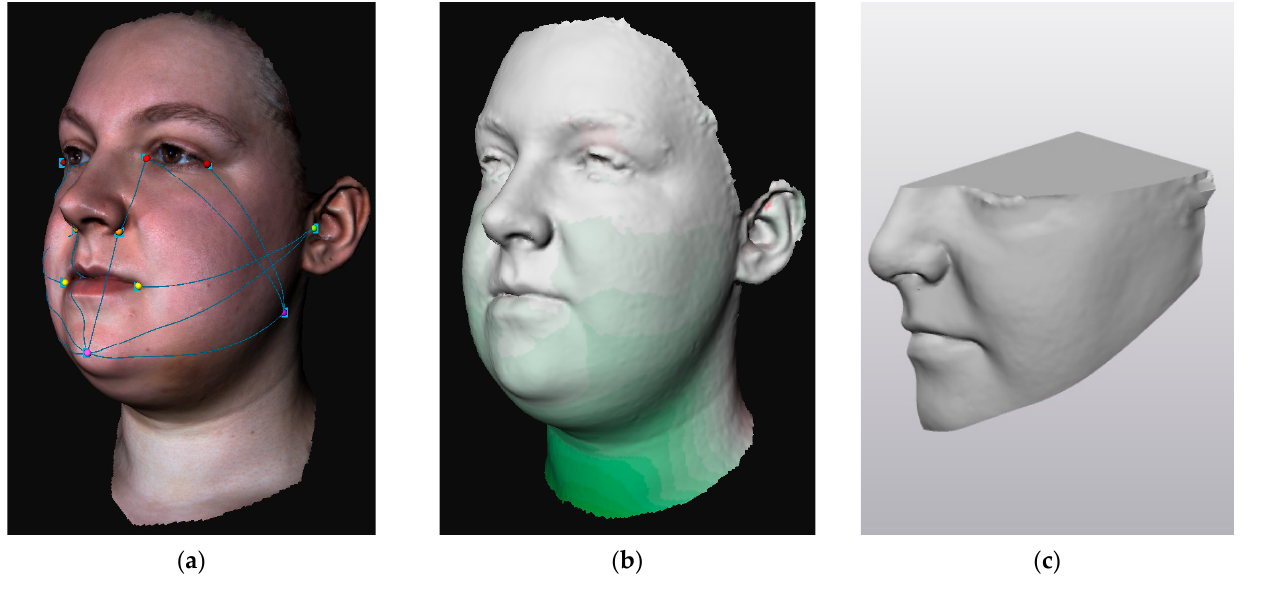
Figure 1. Example of the outcome parameters retrieved from 3D stereophotogrammetry: ( a ) distance measurements of facial categories; ( b ) distance map for obtaining mean and root mean square values; ( c ) closed 3D object of left facial region for obtaining volume difference.